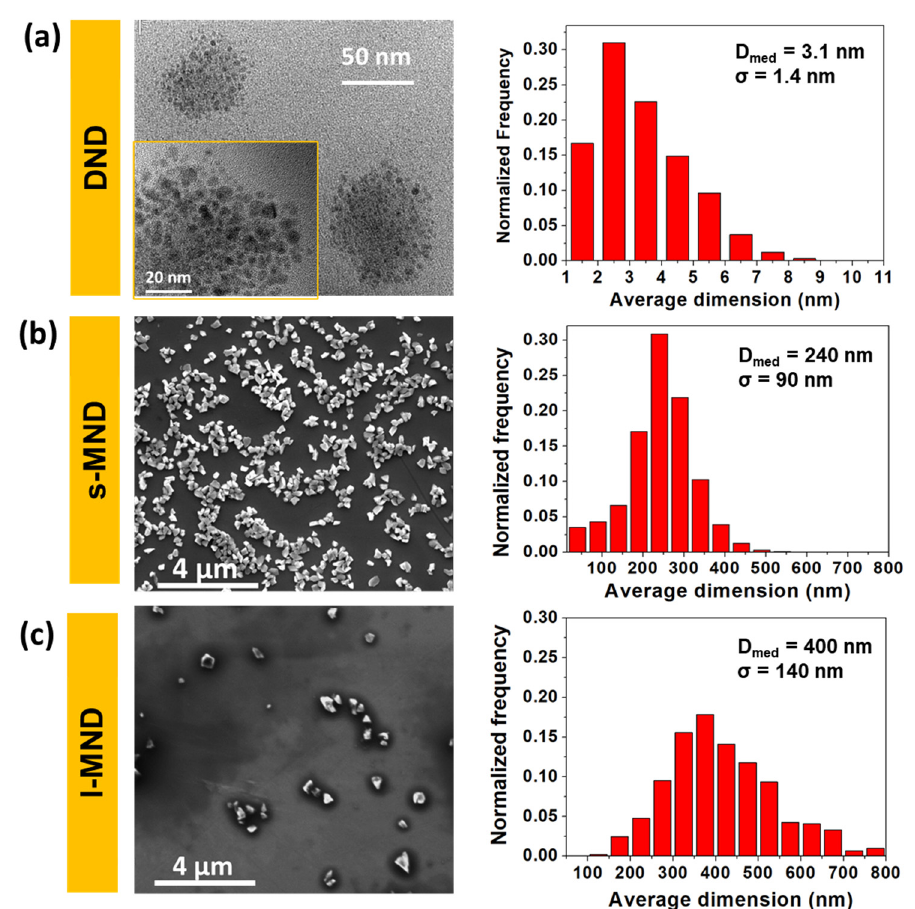
Figure 1. TEM (DNDs ( a )) and SEM (s-MNDs ( b ) and l-MNDs ( c )) images and derived size distributions.